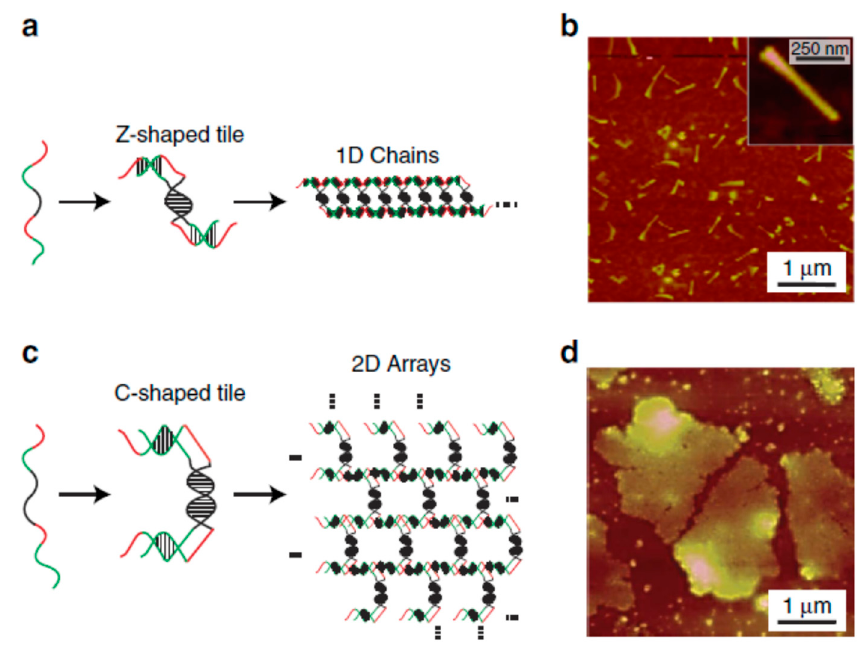
Figure 5. The in vitro genetic-encoding-mediated self-assembly of DNA to different nanostructures: ( a , b ) nanowires and ( c , d ) two-dimensional (2D) nanosheets. Reprinted with permission from [85]. Copyright 2016 Macmillan Publishers Limited. 1D, one dimensional.